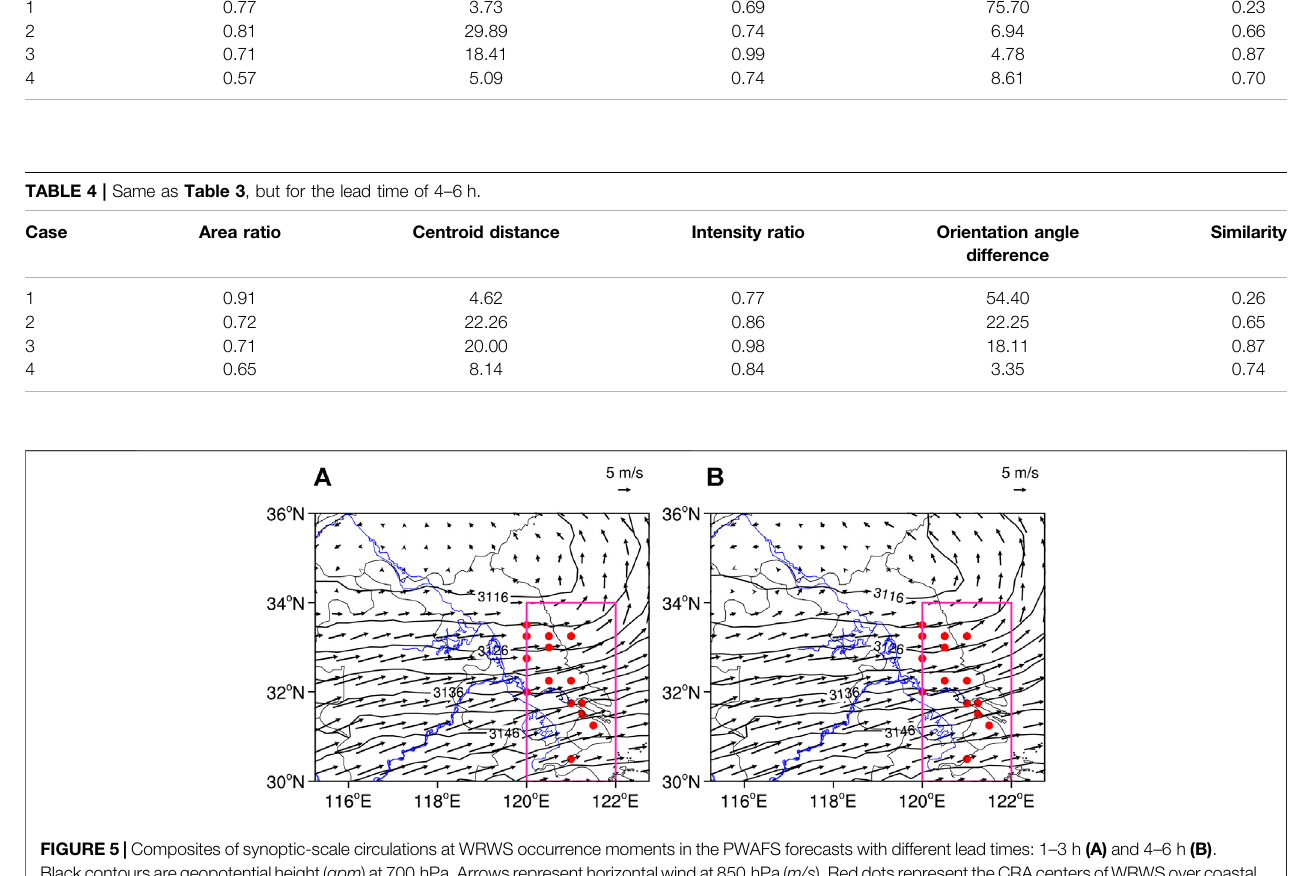
FIGURE 5 | Composites of synoptic-scale circulations at WRWS occurrence moments in the PWAFS forecasts with different lead times: 1 – 3 h (A) and 4 – 6 h (B) . Blackcontoursaregeopotentialheight( gpm )at700 hPa.Arrowsrepresenthorizontalwindat850 hPa( m/s ).ReddotsrepresenttheCRAcentersofWRWSovercoastal areas of YHR (pink